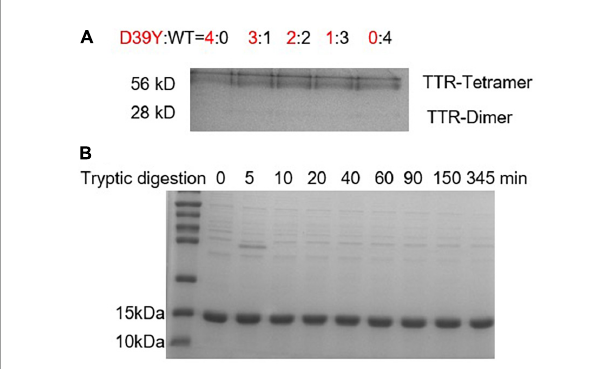
FIGURE4 Heterozygous tetramers of D39Y: WT TTR is stable and resistant to proteolysis. (A) SDS-PAGE electrophoresis analysis of D39Y: WT TTR heterozygous tetramers after crosslinking revealed no increasing dimer bands upon increasing D39Y mutant protein ratio. It suggests heterozygous tetramers of D39Y: WT TTR is kinetically stable. Heterozygous tetramers were prepared at indicated molar ratios of D39Y mutant (red) to WT (black), from 4:0 (D39Y alone) to 0:4 (WT alone), as shown above the gel. (B) SDS-PAGE electrophoresis analysis of D39Y showed proteolytic resistance toward trypsin digestion, suggesting D39Y mutation does not generate proteolytic fragments that lead to amyloid